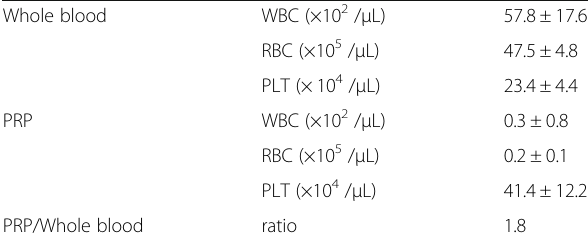
Table 1 Hematological variables of each blood component Whole